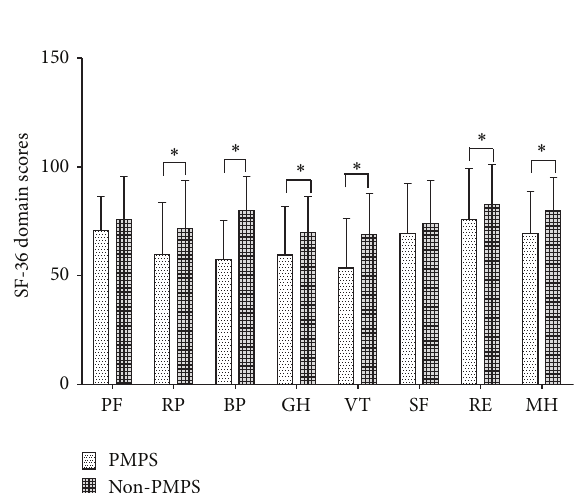
Figure 1: Location of sensory disturbance after breast cancer surgery. 𝑛 = number of patients.